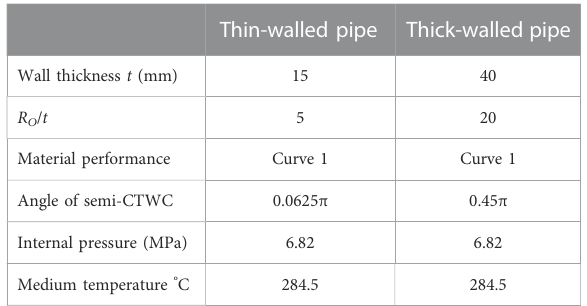
TABLE 4 Input parameters for the leakage rate analysis.